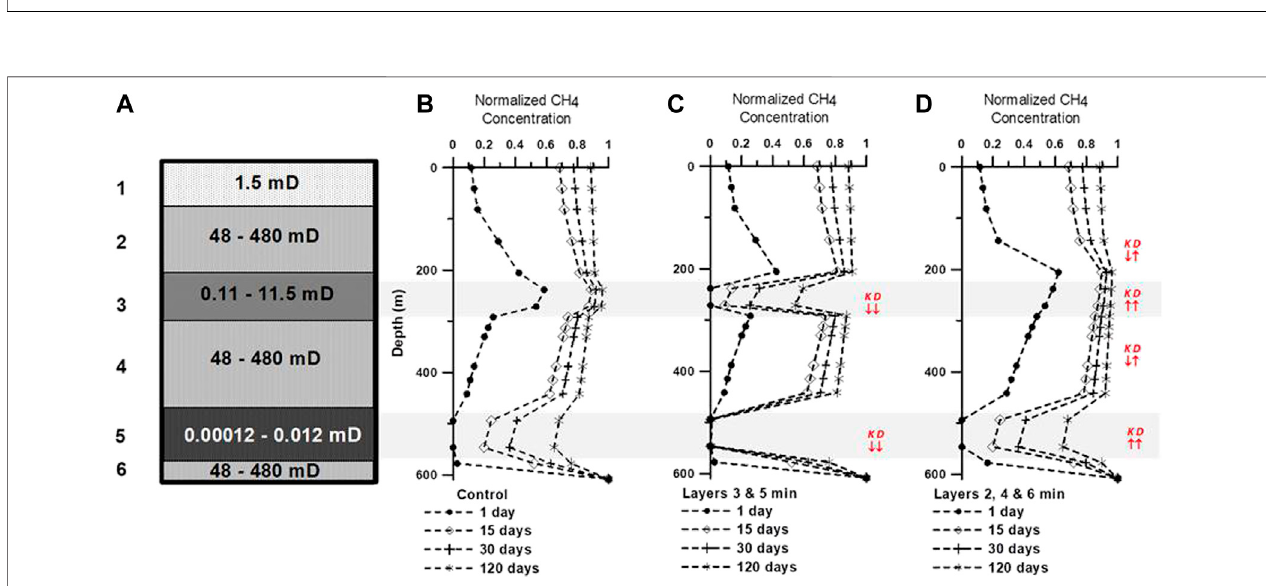
FIGURE 8 | Examples of sensitivity tests in stratigraphic well Saltarin 1A varying the permeability of some speci fi c lithologies and their correlative U and Ds . (A) Arrangementofsedimentarylayers,withtheirpossiblepermeabilityranges.Numericalresultsarecomparedwiththecontrolsequencein (B) (i.e.,maximumpermeability andcorrespondingdiffusioncoef fi cientsinallthelayers)for1,15,30,and120 days. (C) Numericalresultsusing K sminimaof0.11and0.00012 mD(andcorresponding U and D s) in layers 3 and 5, respectively, and keeping the rest of the K s fi xed at their maxima values. (D) Numerical results using a K minimum of 48 mD (and corresponding U and Ds ) in layers 2, 4, and 6, keeping the rest of the K s fi xed at their maxima values. The red arrows besides the pro fi les in (C) and (D) exemplify the increase (arrowup) ordecrease (arrowdown) ofthe K sand D s,relative totheir previous neighboring pro fi lesin (A) and (B) , according totheempirical D/K relationshipof Figure 5